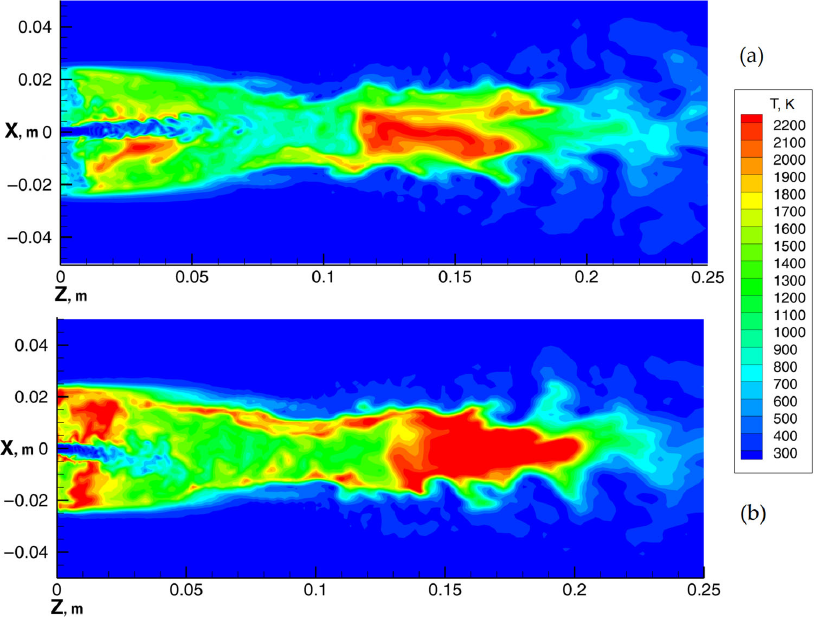
Figure 7. Temperature field, t = 16 ms: Smagorinsky model ( a ), and DSM ( b ). → → The scalar product of fuel and oxidizer gradients, ∇(cid:4652)(cid:4652)⃗𝑌 (cid:3004)(cid:3009) ∙ ∇(cid:4652)(cid:4652)⃗𝑌 (cid:3016) (cid:3120) (cid:3118) , can be used to the location of zones with non ‐ premixed and premixed diffusive combustion. It is a well ‐ known approximate method for combustion mode analysis, which is also known as the Takeno flame index [41]. It is based on the observation that in unpremixed combustion, the fuel and the oxidizer are mostly located on different sides of the flame, and their dif ‐ fusive fluxes (that are counter ‐ directional to the gradients of their concentrations) have opposite directions. On the contrary, in premixed diffusive combustion, the fuel and the oxidizer are mostly located on the same side of the flame, and their diffusive fluxes are codirectional. However, it is important to note that the Takeno flame index based on the gradients of resolved concentrations provides only an approximate estimation of the com ‐ bustion mode because the latter is determined by the local values of gradients on the scale of very small eddies, which are not resolved in the simulation. Figure 8 shows the stoichi ‐ ometric iso ‐ surface 𝑧 (cid:3404) 𝑧 (cid:3046)(cid:3047) colored by the values of ∇(cid:4652)(cid:4652)⃗𝑌 (cid:3004)(cid:3009) . The premixed combus ‐ ∙ ∇(cid:4652)(cid:4652)⃗𝑌 (cid:3016) (cid:3120) (cid:3118) tion areas ( ∇(cid:4652)(cid:4652)⃗𝑌 (cid:3004)(cid:3009) ∙ ∇(cid:4652)(cid:4652)⃗𝑌 (cid:3016) (cid:3408) 0 ) appear near the end of the flame and near the recirculation (cid:3120) (cid:3118) zones. In these regions, our quasi ‐ laminar limitation (13) works. Non ‐ premixed zones ( ∇(cid:4652)(cid:4652)⃗𝑌 (cid:3004)(cid:3009) ∙ ∇(cid:4652)(cid:4652)⃗𝑌 (cid:3016) (cid:3407) 0 ) are situated mostly near the bottleneck. (cid:3120) (cid:3118)